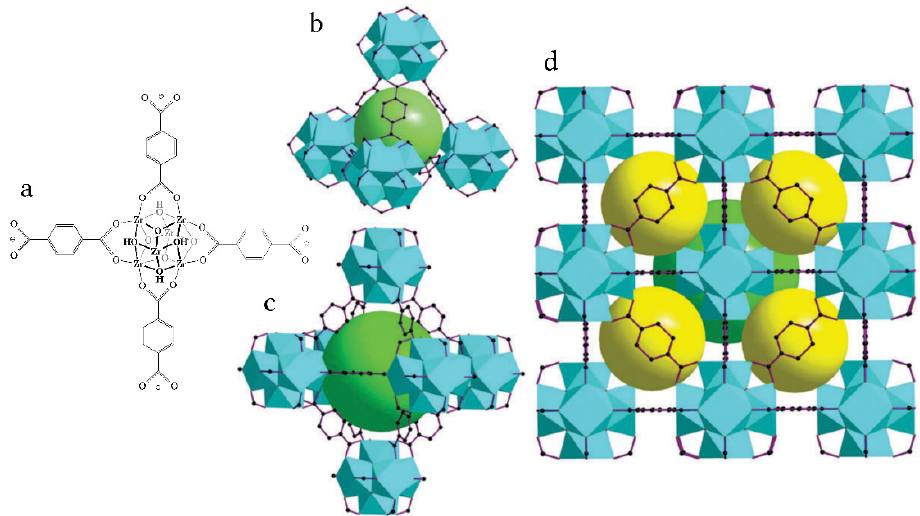
Figure 1. Illustration of the crystalline structure of UiO-66. ( a ) Structure of the inorganic building unit {Zr 6 O 4 (OH) 4 (O 2 CR) 12 }: Zr atoms are located at the vertices of octahedra, which are included in the cubes of the μ 3 -O and μ 3 -OH ligands; every two Zr atoms are connected by carboxylate ligands (only 4 of them are shown for clarity) forming 12 connected nodes; these nodes are combined, forming tetrahedral ( b ) and octahedral ( c ) cavities; ( d ) packing of two types of cavities according to [26]; tetrahedral—yellow; octahedral—green.